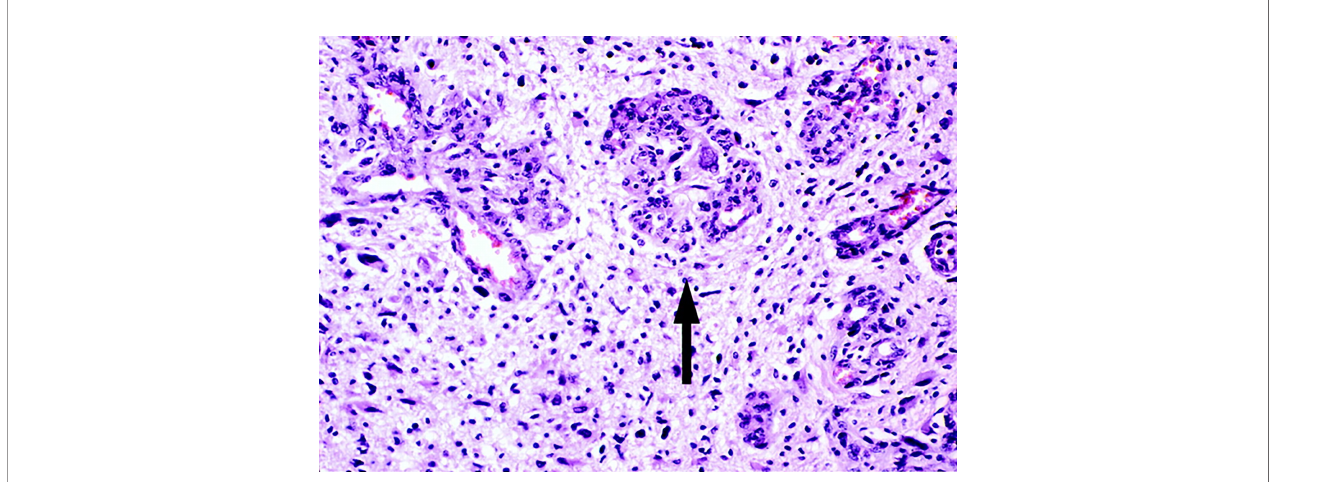
FIGURE 2 | Glomeruloid vascular proliferation in a human glioblastoma multiforme bioptic specimen (arrow). Newly sprouted vessels arranged in tufted aggregates resemble renal glomeruli. Adjacent vessels demonstrate other morphological forms of microvascular hyperplasia in glioblastoma. Blue toluidine staining. Original magni fi cation: x 25 (Reproduced from